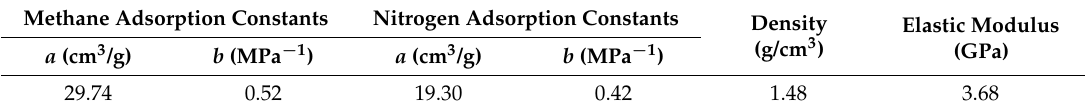
Table 1. Gas adsorption constant, density, and modulus of elasticity of coal